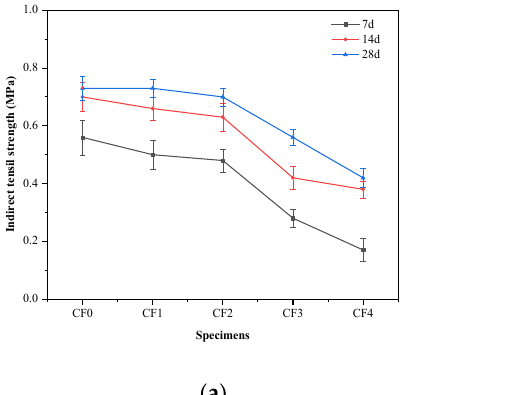
ages to the 7 d strength.